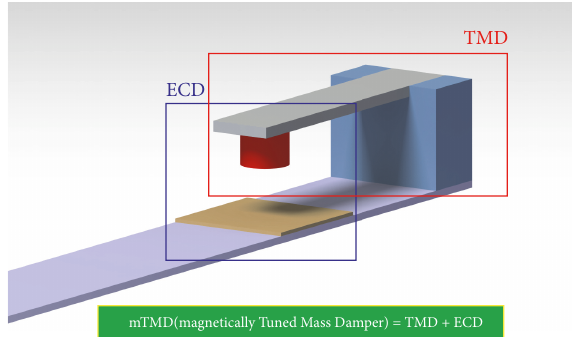
Figure 1: Schematic of magnetically tuned mass damper [10].